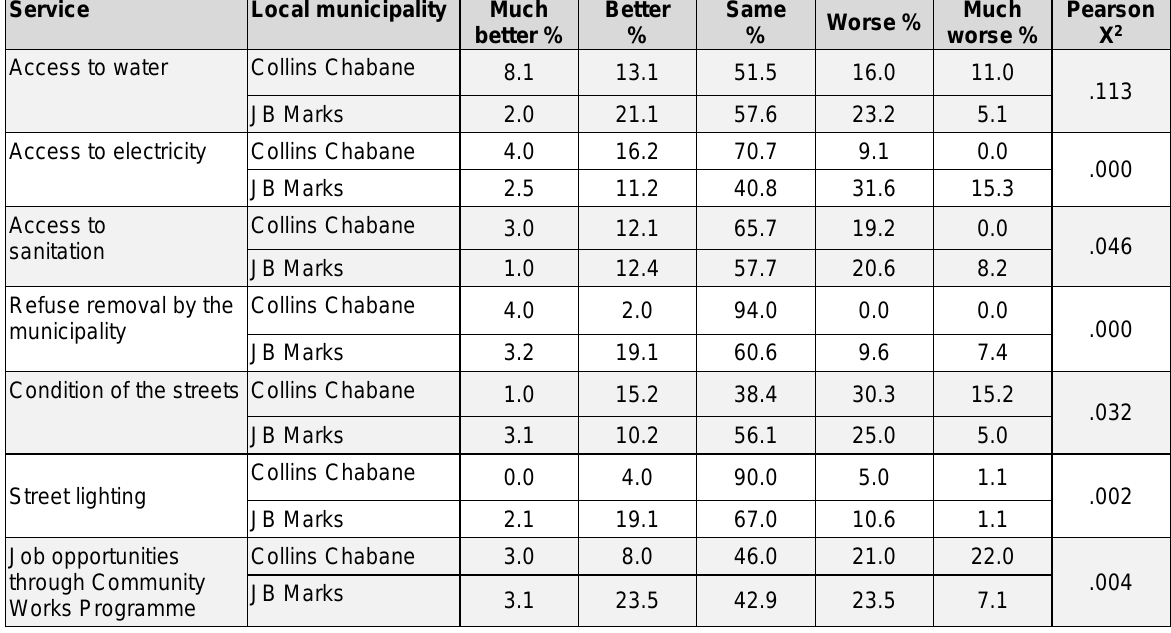
Table 7: How has the merger affected the delivery of services? Service Local municipality Much